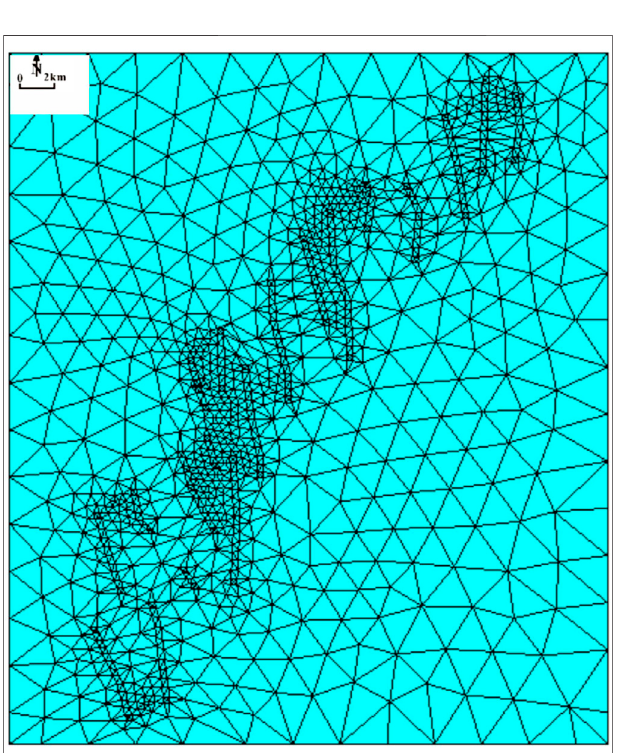
FIGURE 4 | Grid model of Silurian in Shunbei A Strike-Slip Fault Zone in Tarim Basin.